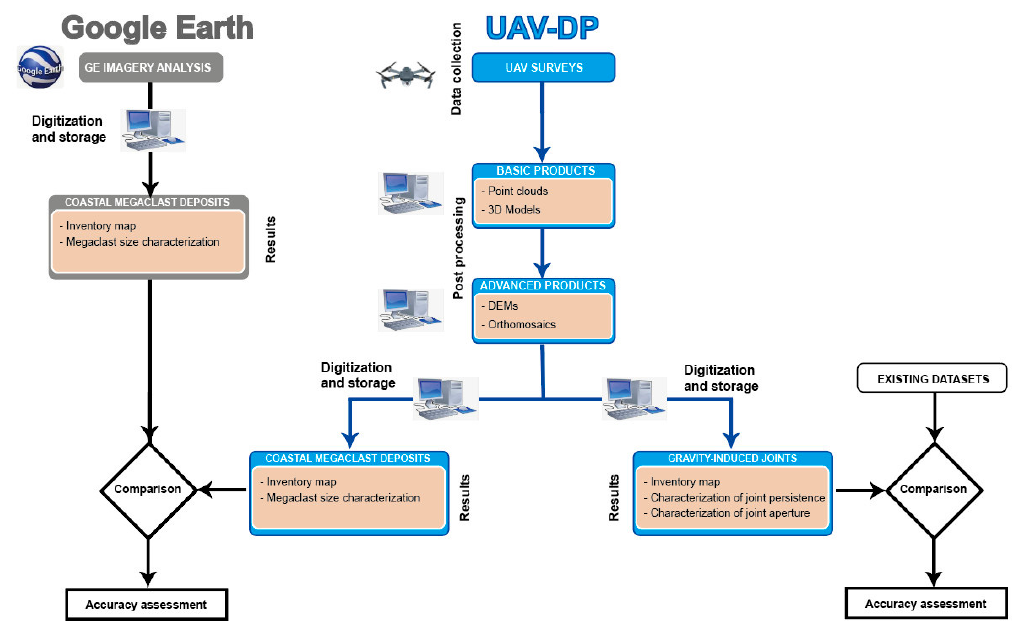
Figure 7. Workflow of GE imagery analysis and UAV-DP procedures.